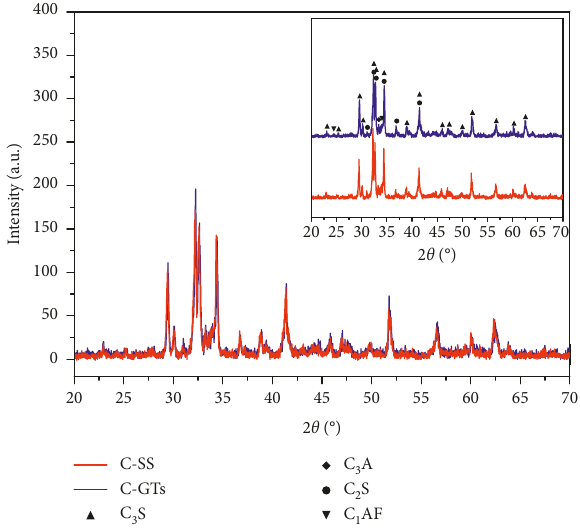
Figure 5: XRD patterns of cement